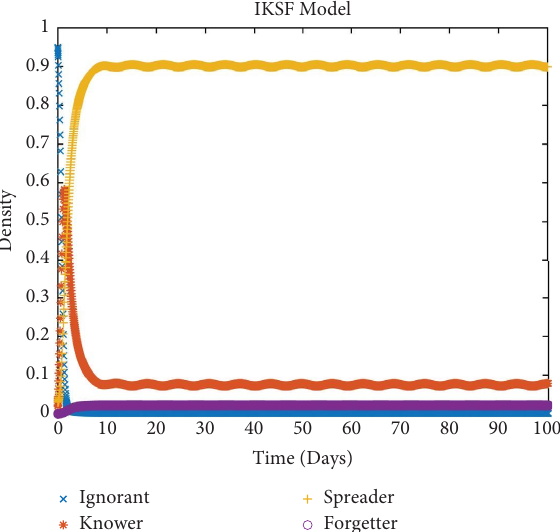
Figure 17: Diagram of knowledge transmission with guaranteed cost control.